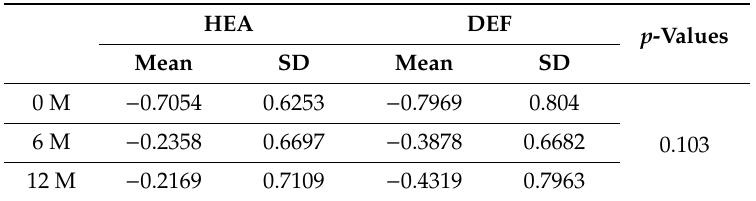
Table 6. Bone Position / Groups.